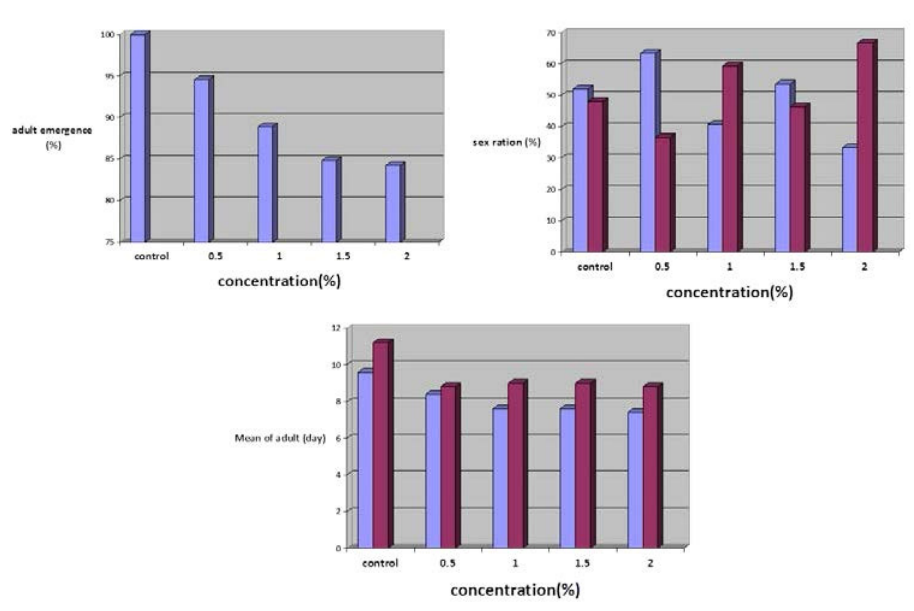
A: Fig. 7. Effect of Different Concentrations of Bacillus thuringiensis israelensis on The Percentage of Mature Emergence M. domestica Treated as 2 nd Larval Instar. B: Fig. 8. Effect of Different Concentrations of Bacillus thuringiensis israelensis on Sex Ration of M. domestica Treated as 2 nd Larval Instar. Fig. 9. Effect of Different Concentrations of Bacillus thuringiensis Israelensis on Mature Life Span M. domestica Treated as 2nd Larval Instar.